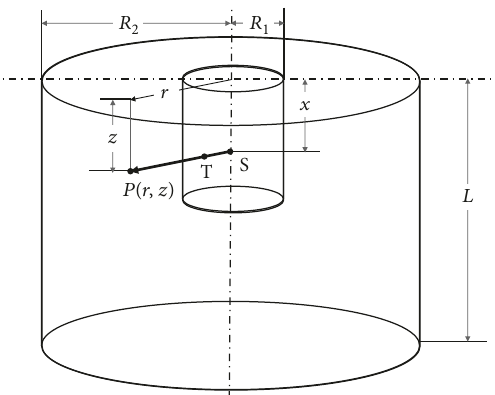
Figure 2: Cylindrical photoreactor with a cylindrical light